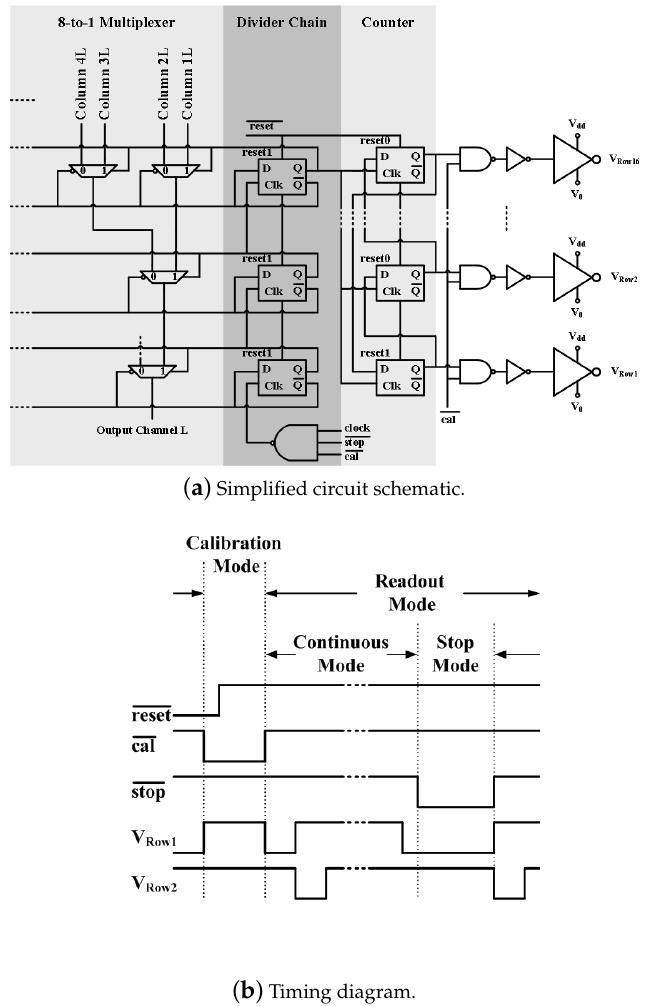
Figure 6. The logic control circuit. ( a ) The schematic shows only half of the 8-to-1 multiplexer. The reset signal is routed through some of the D-latches simply to reduce clutter in the figure; ( b ) The timing diagram is an illustration of the chip’s operation modes; the clock and all the control signals reset, cal, and stop are provided